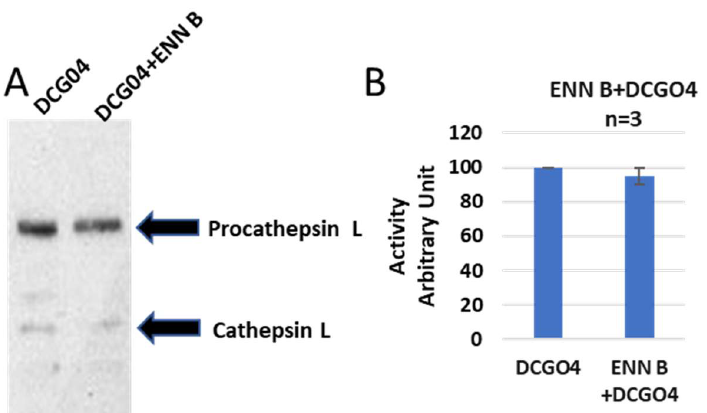
Figure 4. Avidin pull-down experiment of cysteine cathepsins before and after ENN B treatment. ( A ) Avidin pull-down experiment was performed as described in materials and methods. Conjugated proteins to avidin Sepharose beads were subjected to protein electrophoresis and Western blotting with antibodies specific to human cathepsin L. ( B ) Ratio of cellular contents of cathepsin B before and after treatment with ENN B. The data were analyzed by t -test and statistics using GraphPad Prism. Graphs are shown as mean ± SE, N = 7.